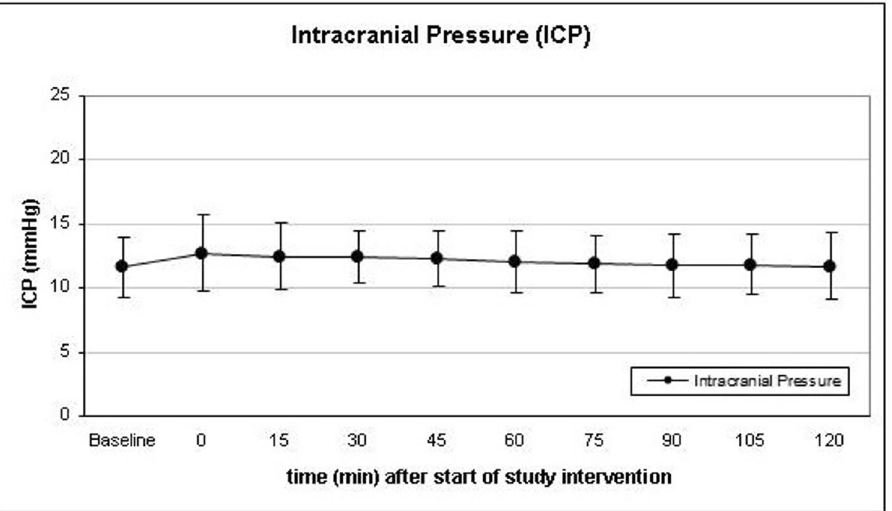
Figure 2. Course of intracranial pressure (ICP) during the study intervention. All patients had an external ventricular drainage which was allowed to continuously drain cerebrospinal fluid during the intervention. No relevant increase of ICP was observed during the monitoring period. Data presented as Mean ± SD; 1-way ANOVA for Repeated Measurements; *p < 0.05, **p < 0.01, ***p < 0.001, plots and error bars presented as Mean ± SD (standard deviations).